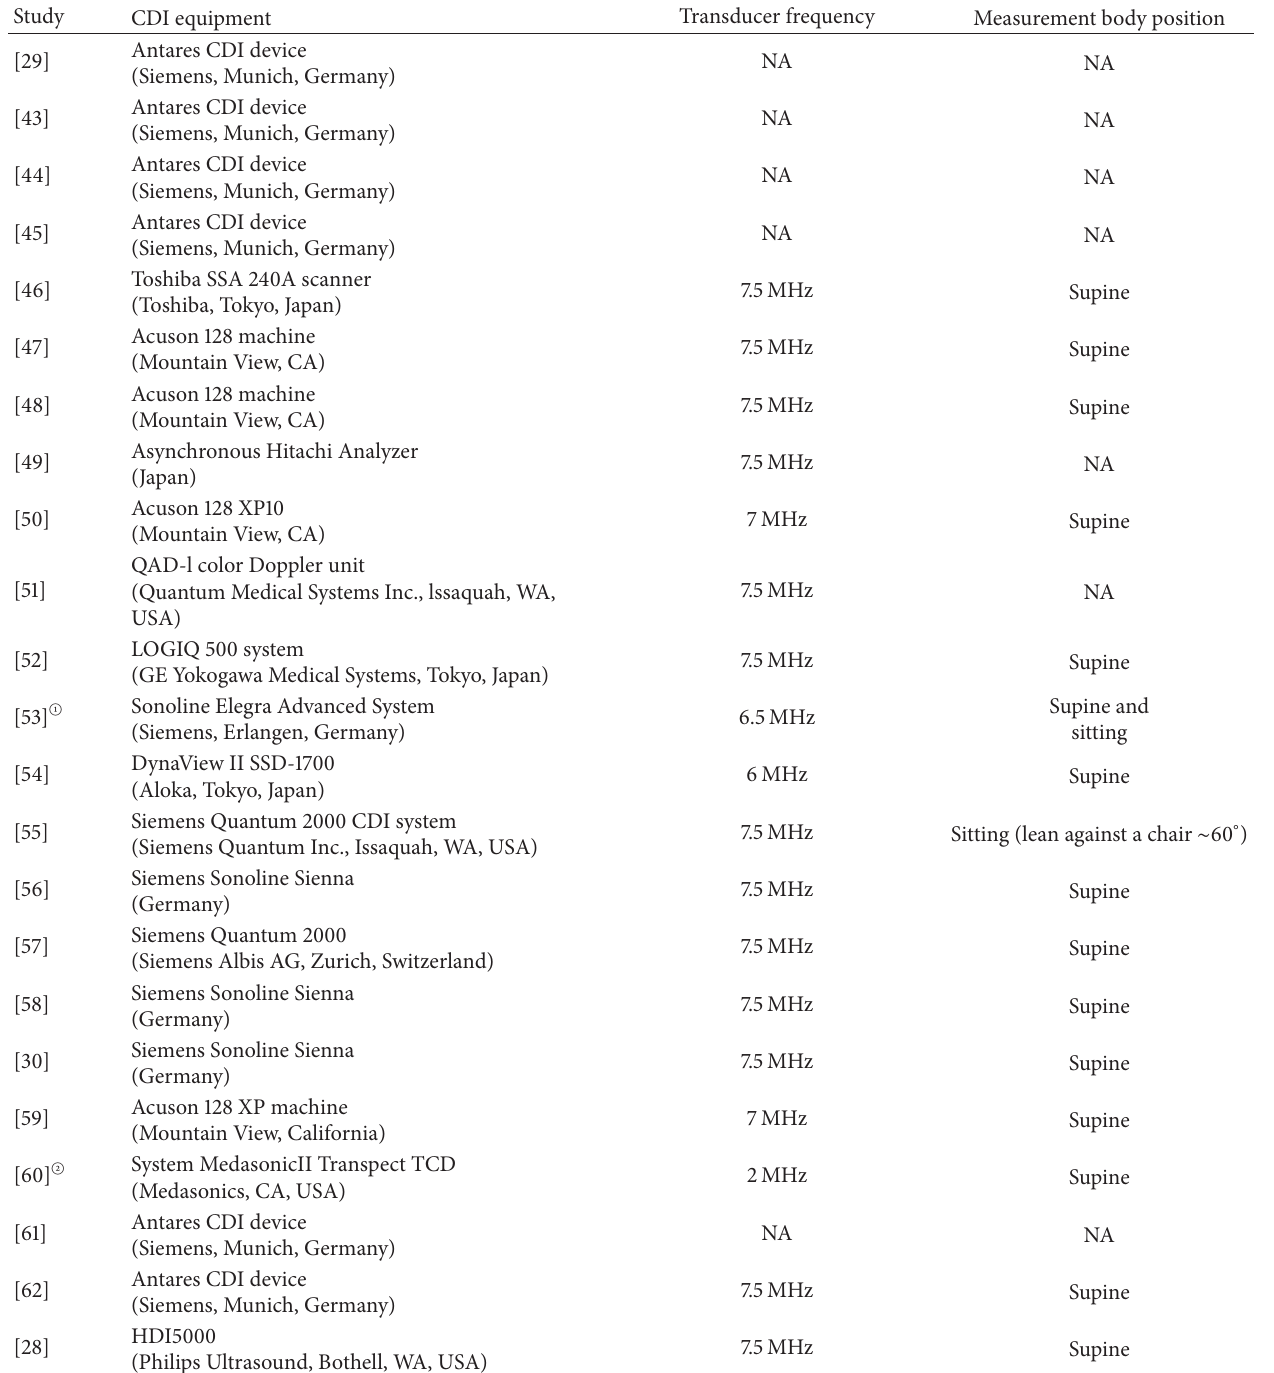
Table 3: Examining equipment and eye selection of the included